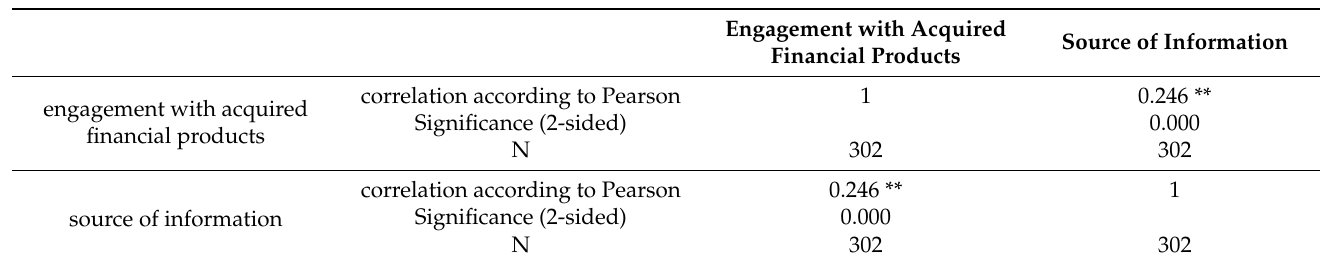
Table 3. Correlations H1.